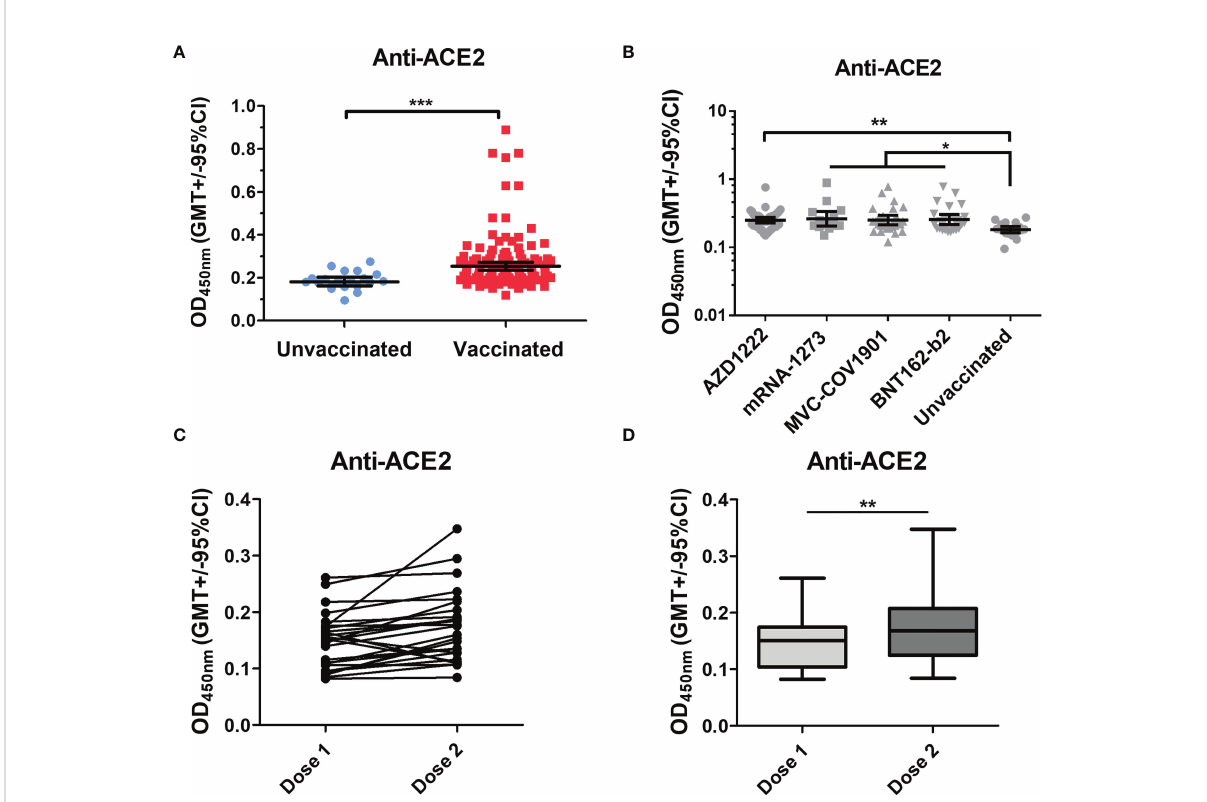
FIGURE 2 Anti-ACE2 Abs signi fi cantly increased in the COVID post-vaccination group. (A) Anti-ACE2 antibodies in the sera of pre-pandemic and vaccinated groups were tested. (B) The vaccinated group was separated into four groups (AZD1222, mRNA-1273, MVC-COV1901, and BNT162- b2), and the anti-ACE2 antibodies in the sera of these groups were compared with the pre-pandemic group. (C, D) Anti-ACE2 antibodies in the vaccinated sera after the fi rst dose (dose 1) and the second dose (dose 2) were detected by an indirect ELISA. *P<0.05, **P<0.01,